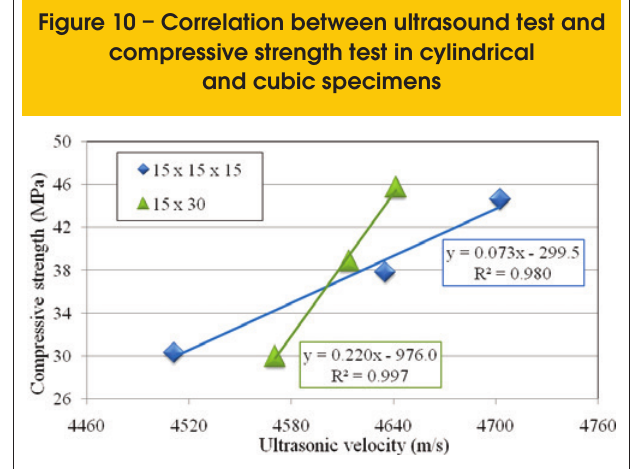
Figure 10 – Correlation between ultrasound test and